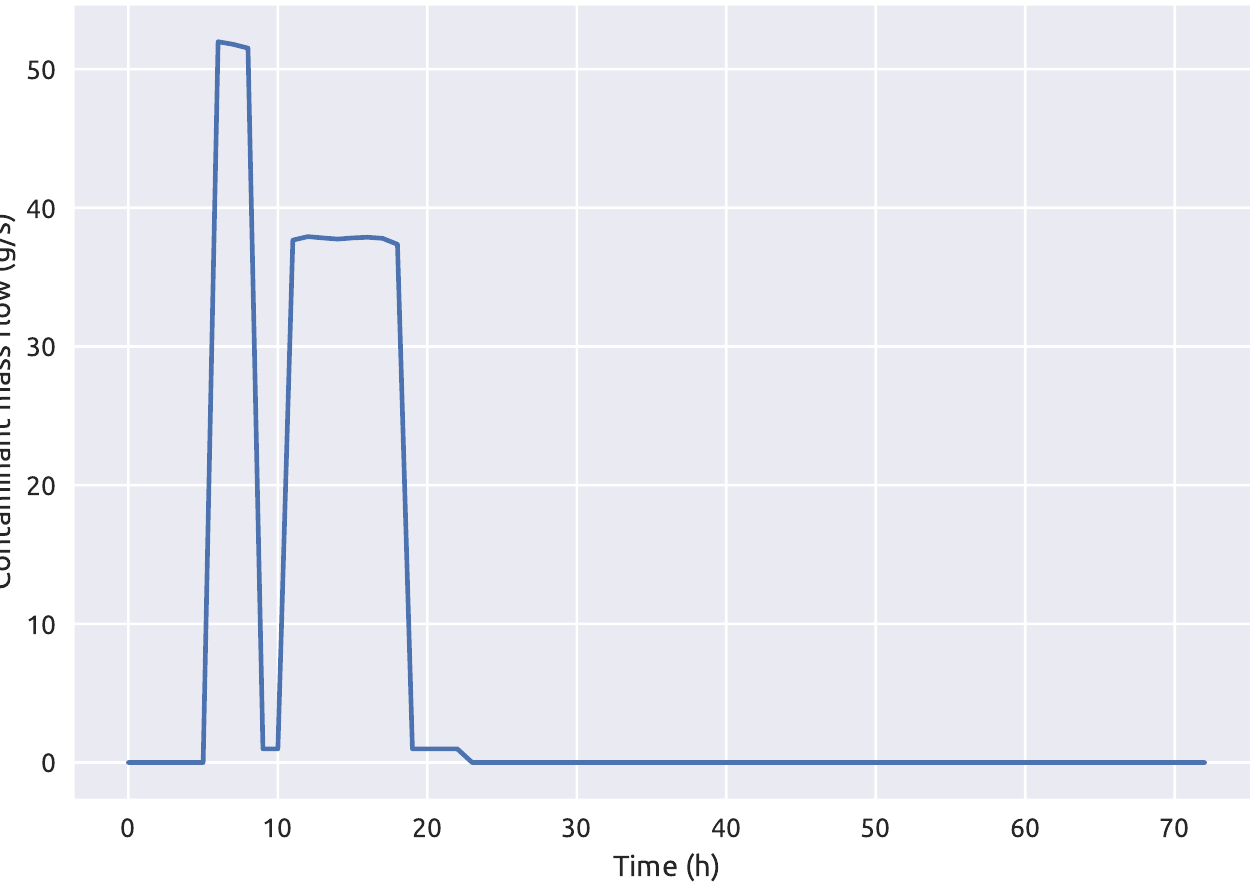
Figure 10. Average contaminant mass flow at the source node 251 for the Richmond network over a 72 h